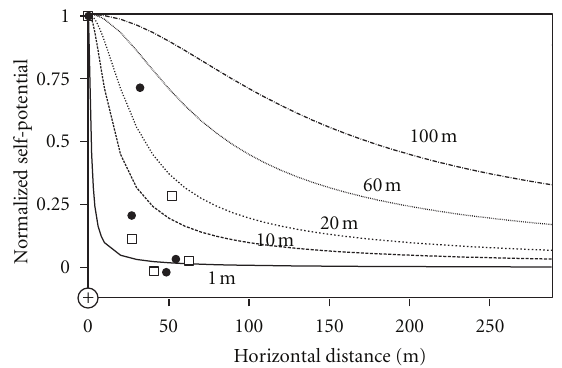
Figure 6: Calculated SP from various depths of a point source (1– 100m). The SP values are normalized by the respective value at 0 m in the horizontal distance where the source is located. The observed SP anomalies “A” and “B” in Figure 5(b) are shown by circles and rectangles, respectively.